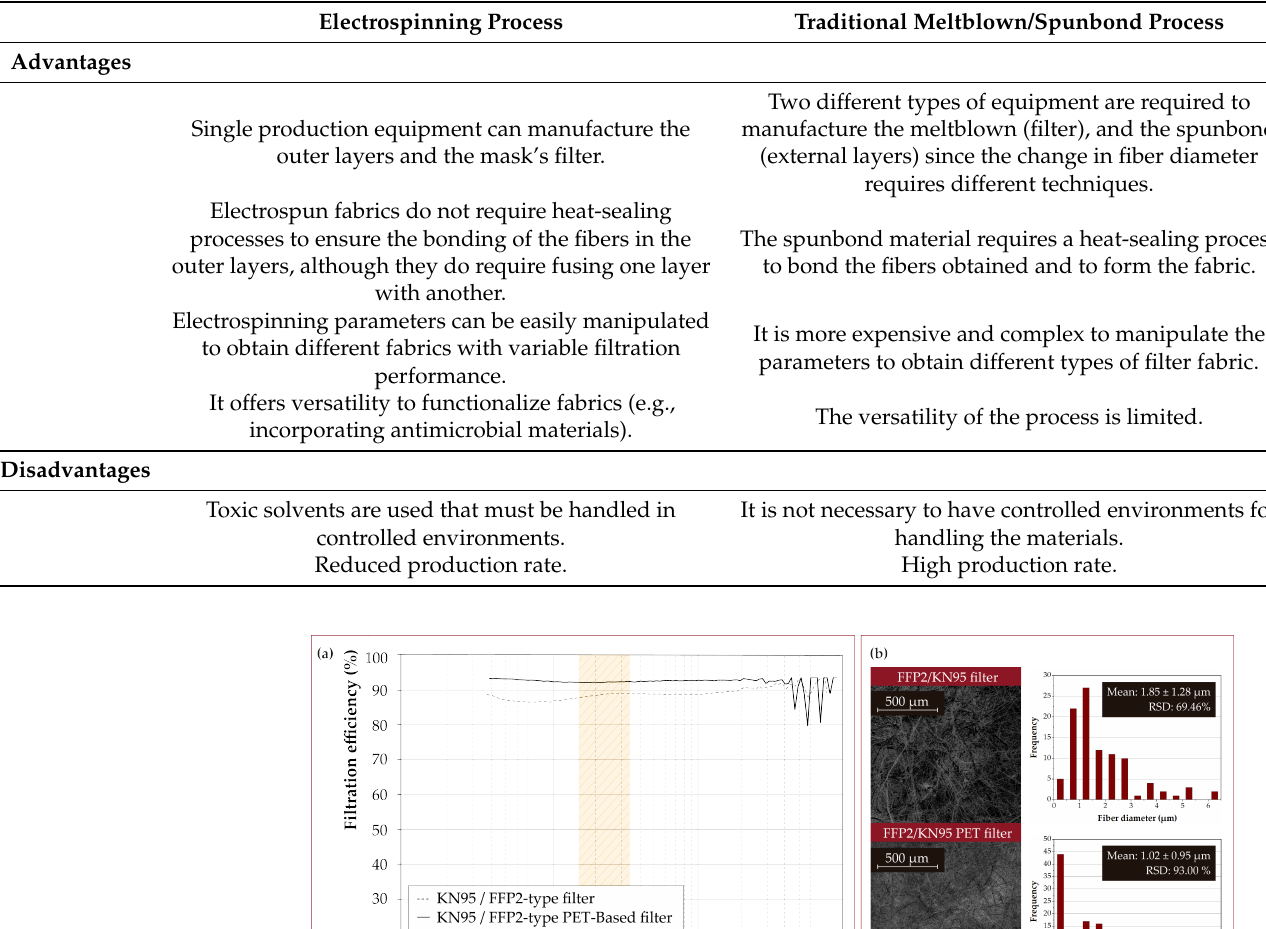
Table 5. Advantages and disadvantages of the electrospinning process.